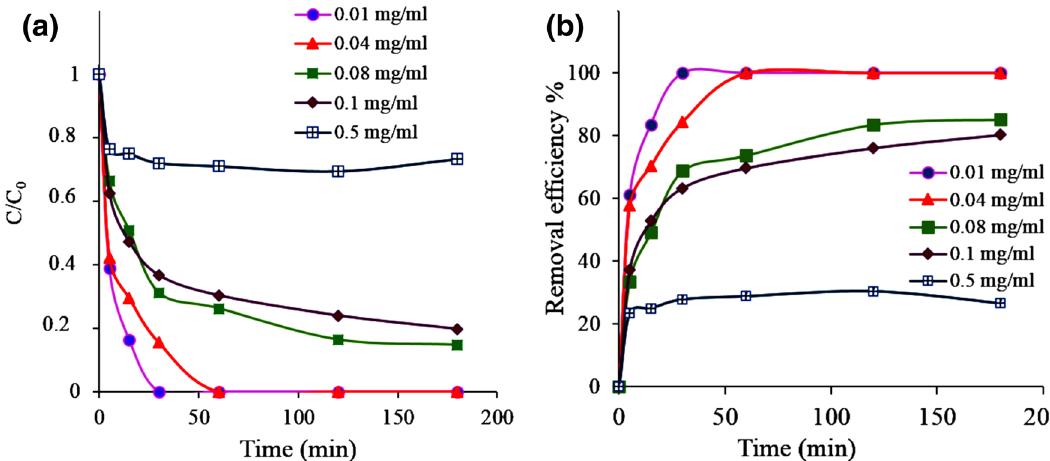
Figure 8. The effect of initial dye concentration on adsorption of AG-25 by Ch-rGO/Fe 3 O 4 . Experimental conditions: adsorbent dose 0.010 g, RT, and natural